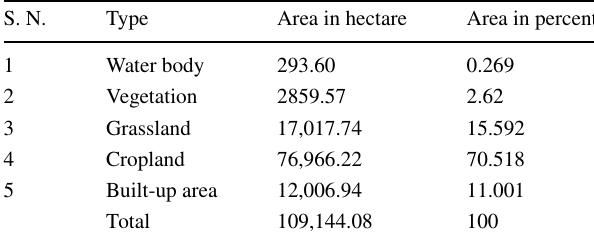
Table 5 Land covers areas in 2020